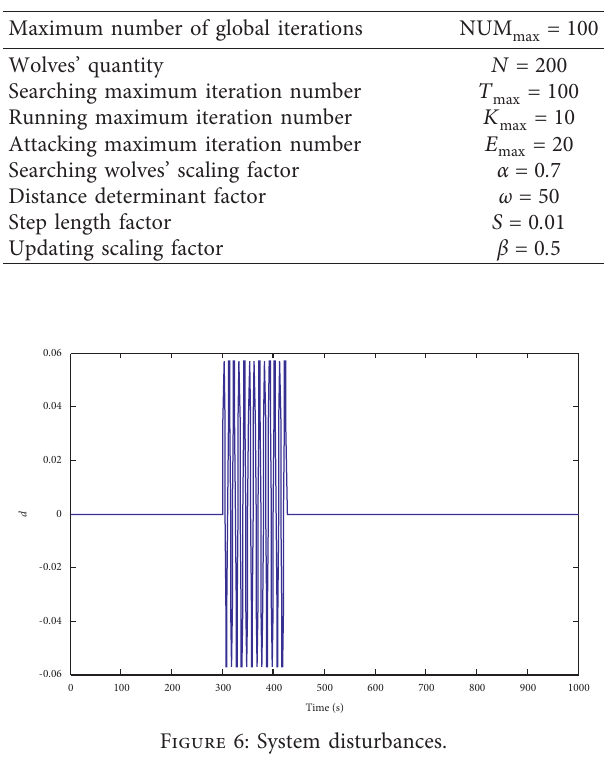
Table 4: Initialization parameters of GWO.